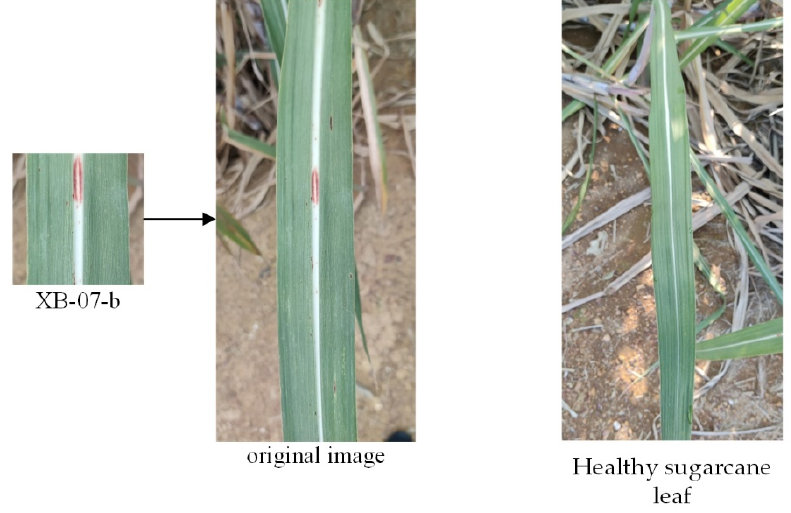
Figure 12. Comparison of pictures of misclassified red rot and healthy sugarcane leaf.